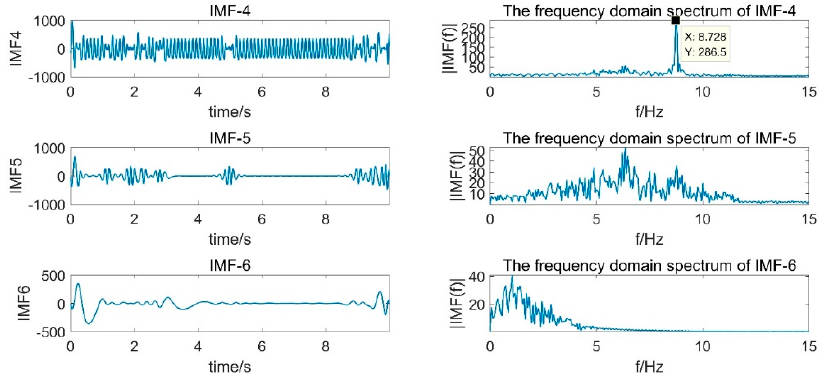
Figure 13. Part of the IMF component obtained by EMD decomposition of the acceleration signal.